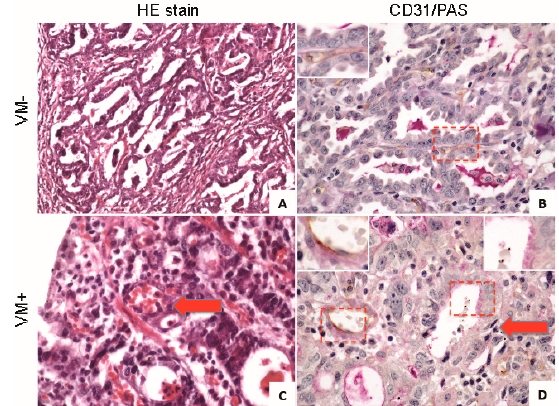
Figure 2. Vasculogenic mimicry in gastric adenocarcinomas: ( A , B ) Gastric adenocarcinoma sample negative for vasculogenic mimicry (VM), stained with hematoxylin and eosin (HE; Panel A , magnification 200×) or with a dual stain for the endothelial cell marker CD31/PAS (600×); Inset in Panel B (upper left) shows a CD31+ (brown) vessel between two glands; ( C , D ) VM+ adenocarcinoma sample. Panel C (600×) shows an HE stain, red arrow shows a vessel that contains red blood cells in its lumen; Panel D , CD31/PAS stain (600×) demonstrates two types of vessels. Upper left inset shows a CD31+ (brown, EC marker) vessel. Red arrows highlight a tumor gland CD31 − (no brown) PAS+ that contains red blood cells in its lumen. Upper right inset shows a magnification of PAS+/CD31 − vessel (VM+). Red frames in panels B and D indicate the area magnified in the respective insets.